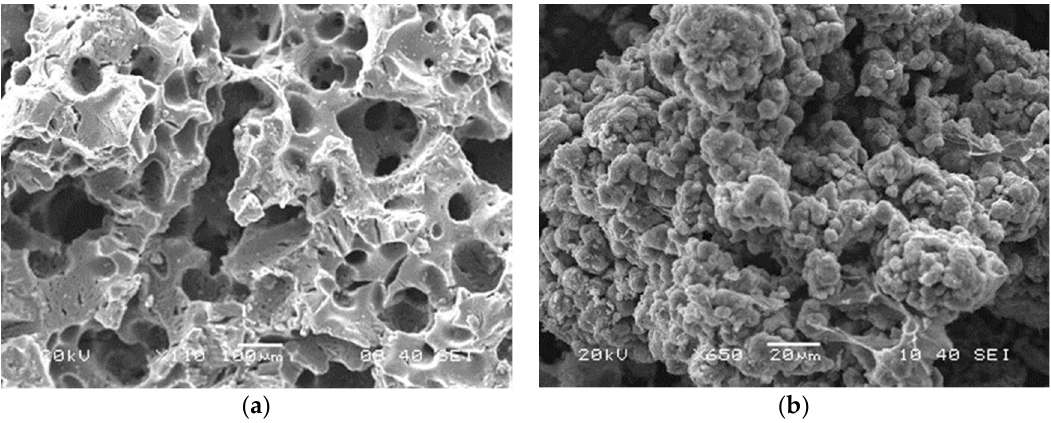
Figure 10. ( a ) SEM for AAJPL surface before adsorption; and ( b ) SEM for AAJPL surface after Figure10. ( a )SEMforAAJPLsurfacebeforeadsorption; and( b adsorption.